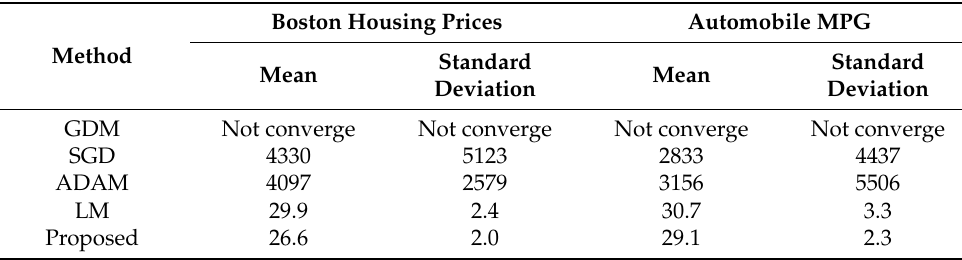
Table 4. Boston housing prices and automobile MPG training performances using early stopping (validation patient of 15)—number of